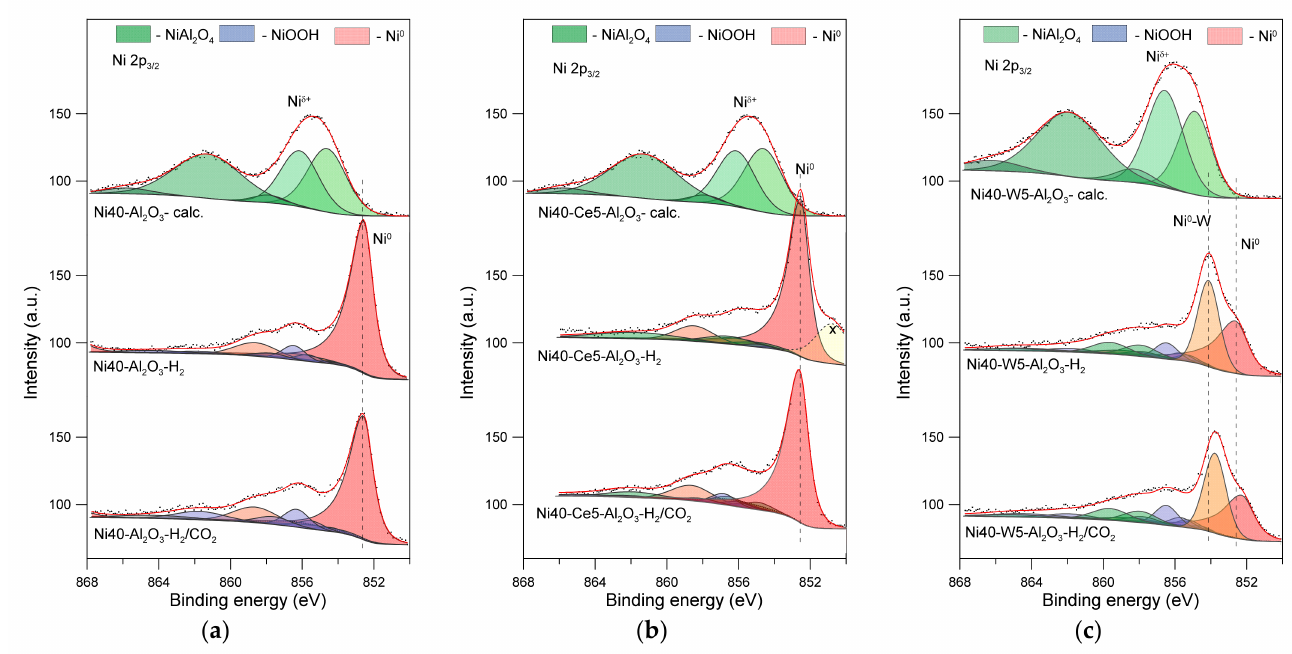
Figure 9. Ni 2p 3/2 XPS spectra of catalysts after calcination (-calc.) ( a ), activation in hydrogen (-H 2 ) ( b ), and CO 2 methanation reaction (-H 2 /CO 2 ) ( c